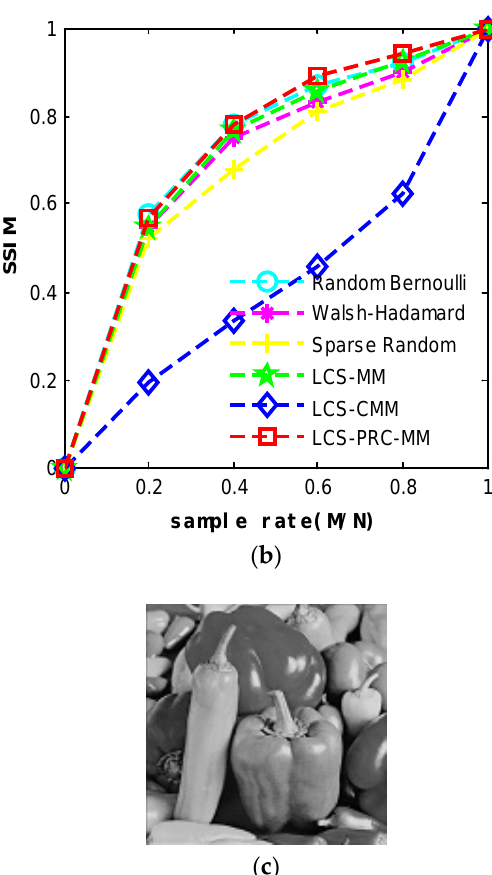
Figure 4. Comparison of the reconstruction of the target image with the TVAL3 recovery algorithm under different measurement matrices: ( a ) analysis of reconstruction results by using PSNR, ( b ) analysis of reconstruction results by using SSIM, and ( c ) target image.